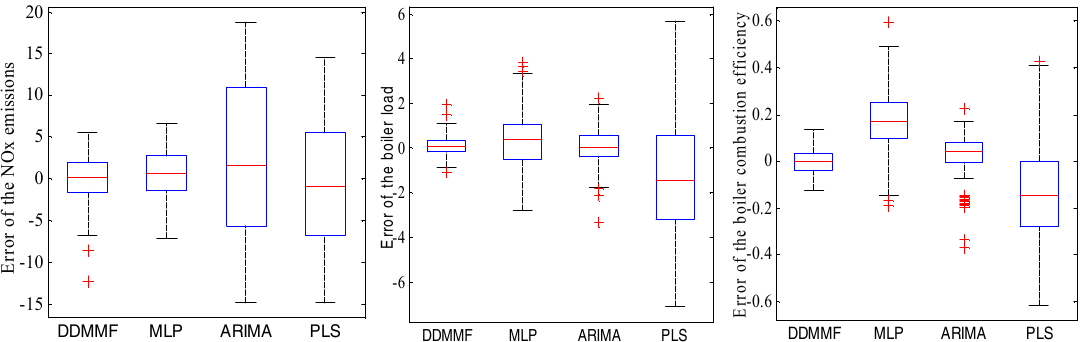
Figure 6. The prediction errors obtained from di ff erent prediction models for operating condition 2 Figure6. The prediction errors obtained from different prediction models for operating condition 2